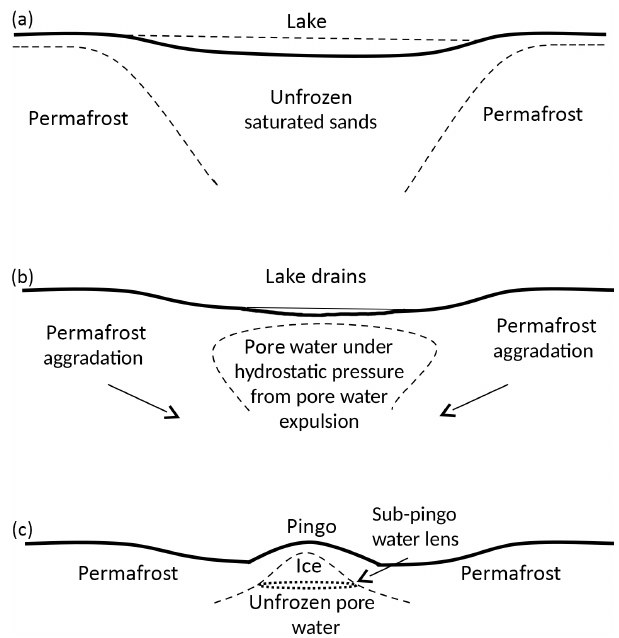
Figure 1. Growth of closed-system pingo (modified from Mackay (1998)): (a) lake underlain by basin of unfrozen saturated sands; (b) lake after rapid drainage, showing permafrost aggradation, pore water expulsion, and hydrostatic pressure increase beneath residual pond with thin layer of permafrost; (c) growing pingo underlain by sub-pingo water lens.